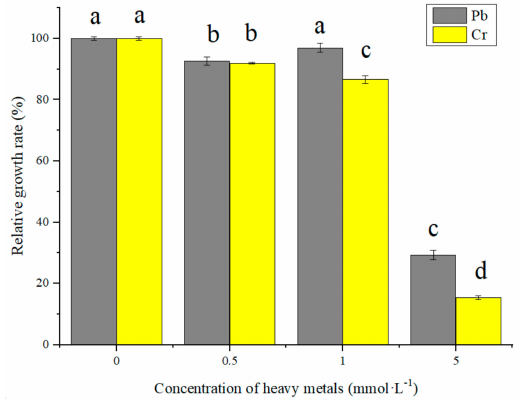
Figure 1. Relative growth rate of Bacillus sp. MRP-3 under Pb and Cr stress compared with control group. Bars with di ff erent letters (a–d) are significantly di ff erent at p < 0.05.